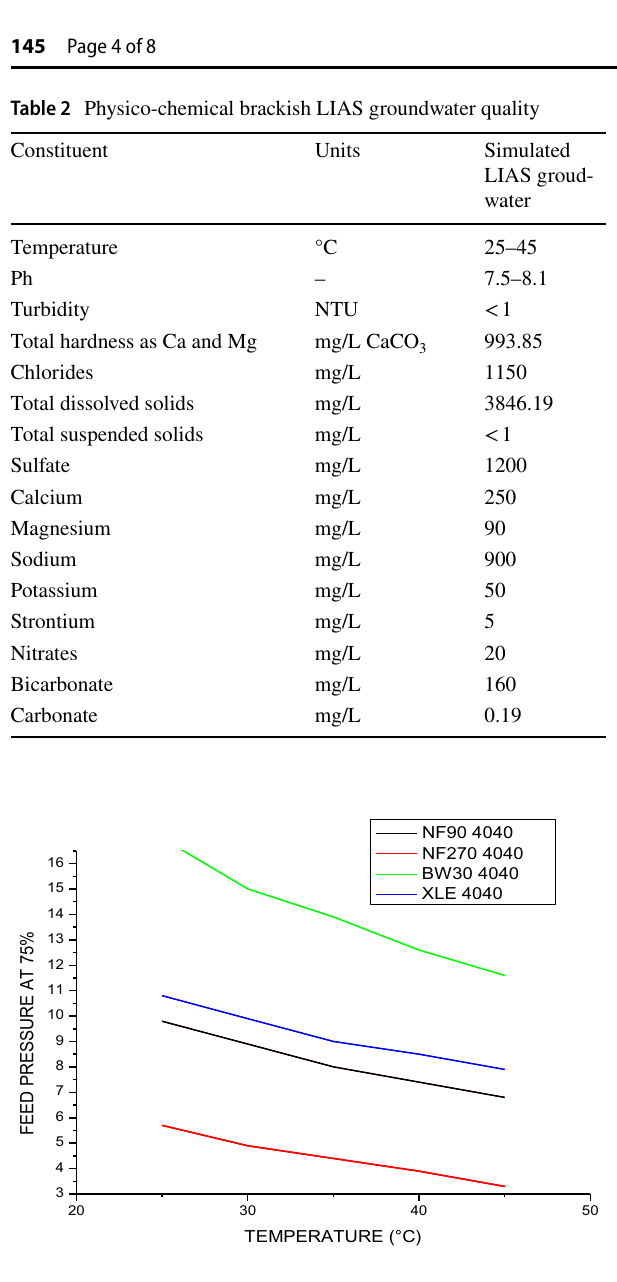
Fig.2 Effect of temperature on feed pressure to achieve 75% of RR